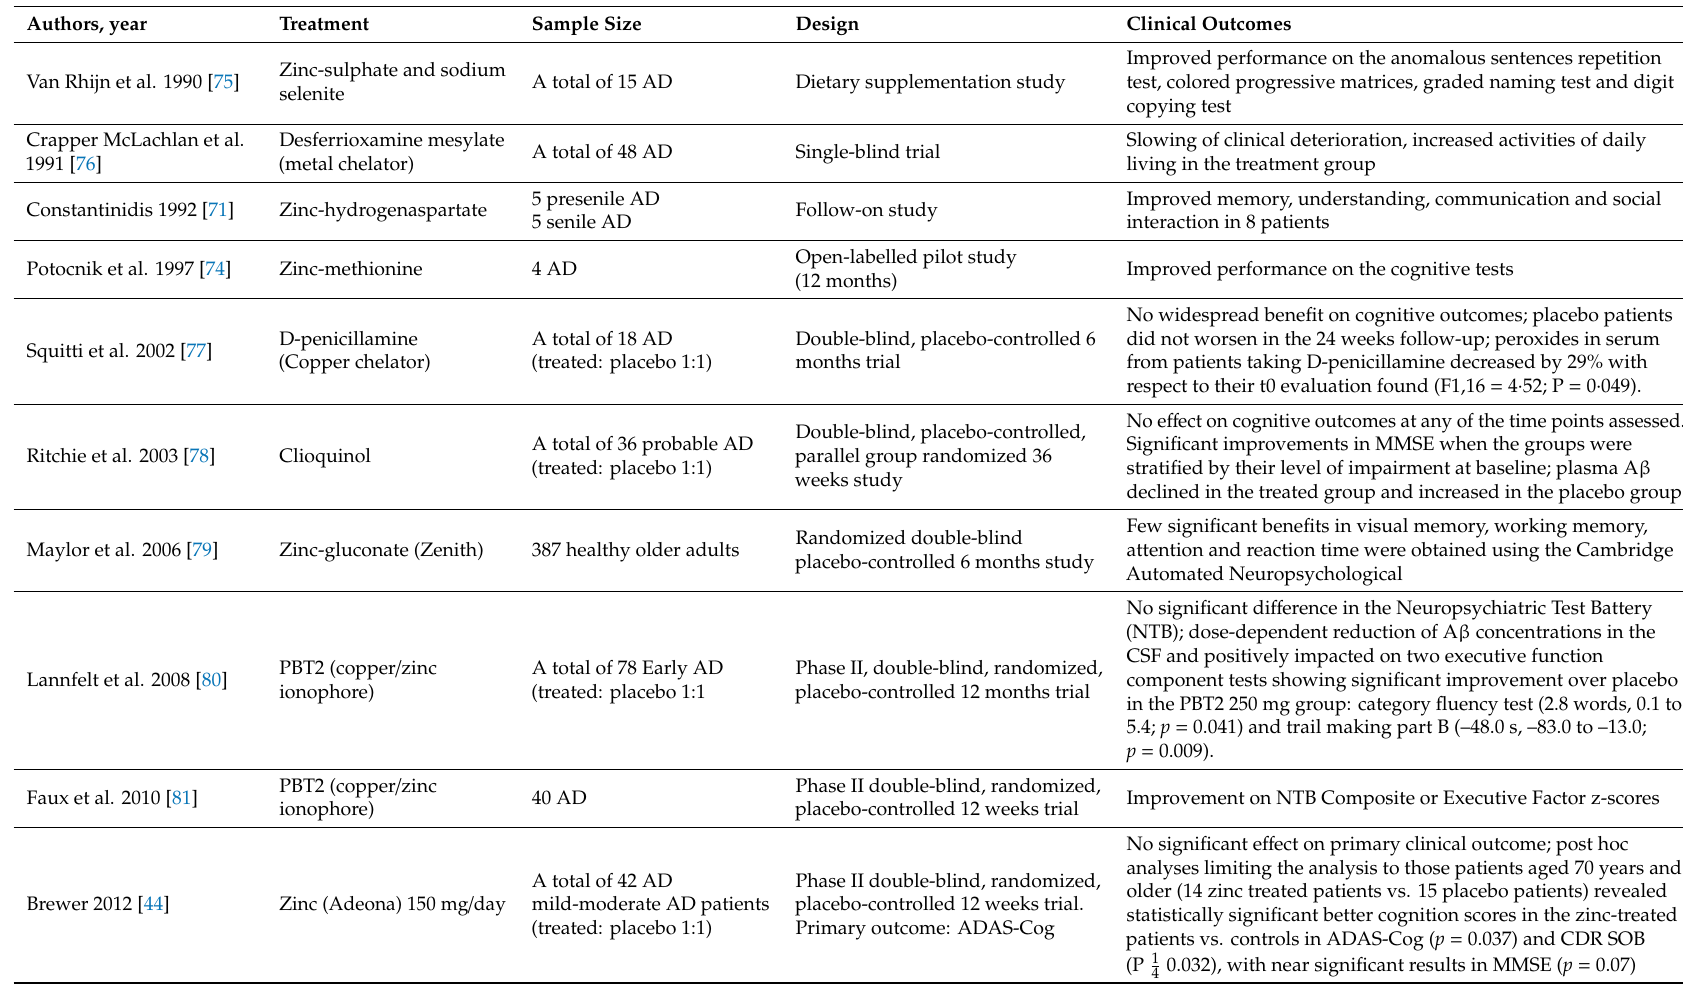
Table 2. Clinical trial testing anti-copper-based therapies on cognition and Alzheimer’s